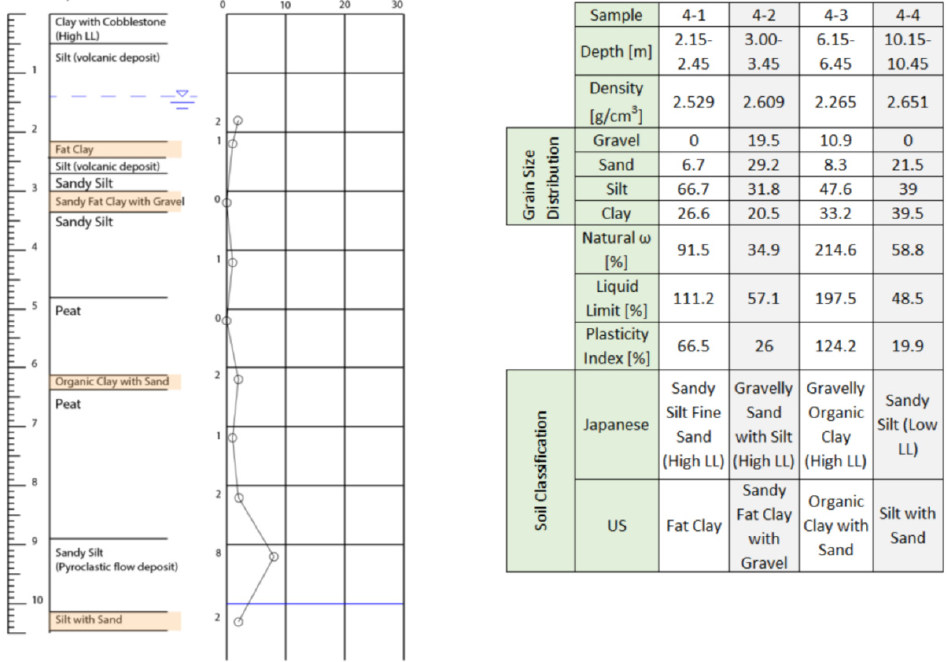
Figure 16. SPT characterization, interpreted soil profile, and laboratory index test results for Site 4 (after Anderson [40]).